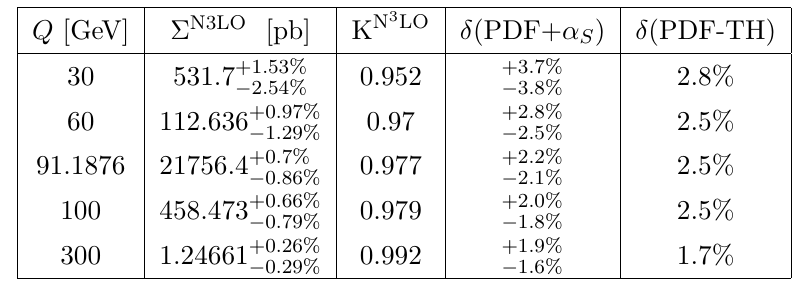
Table 2. Cross section values for a selection of representative invariant mass Q for the choice of central scale µ F = µ R = Q , together with the corresponding QCD K-factors and uncertainties (see main text for a detailed